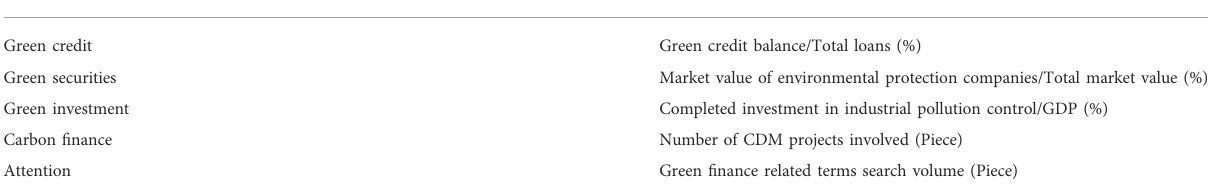
TABLE 1 Evaluation system of green fi nance development